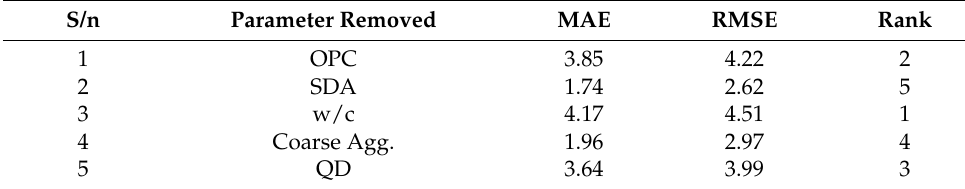
Table 11. Sensitivity Analysis Computation.